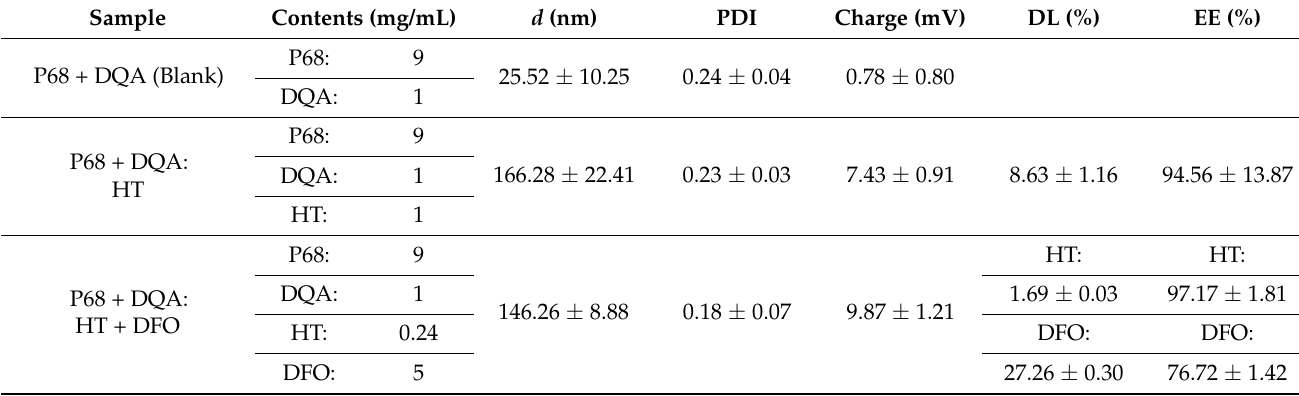
Table 1. Hydrodynamic diameter (d), polydispersity index (PDI), surface charge, drug loading (DL) and encapsulation efficiency (EE) of blank and drug-loaded P68 + DQA nanoformulations prepared at 80 ◦ C (mean ± S.D., n = 6).